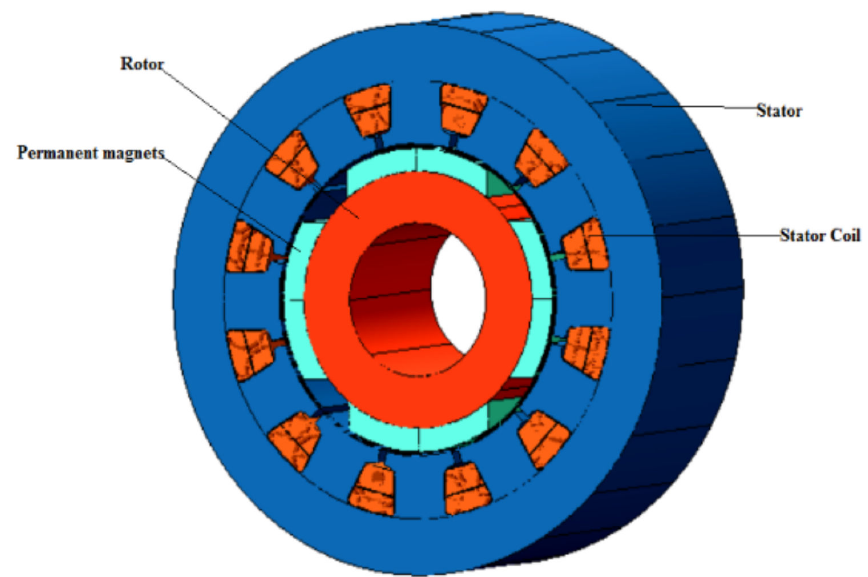
Figure 1. Topology of surface-mounted BLDC motor.